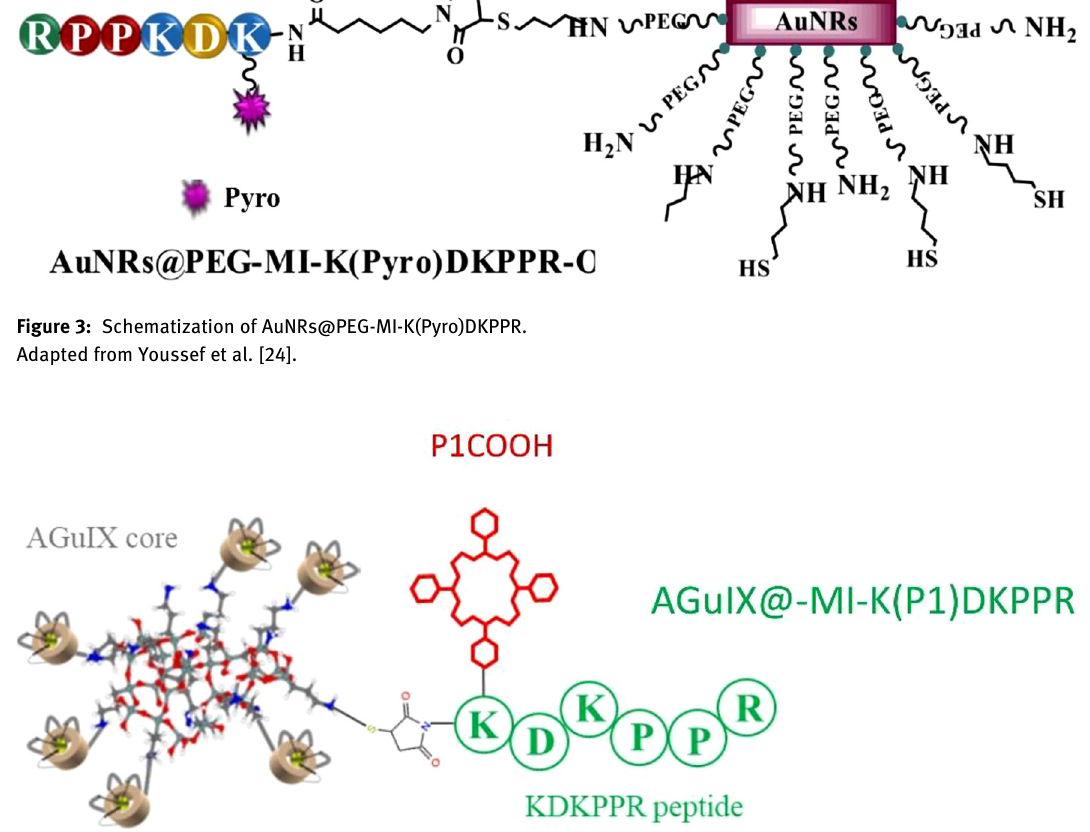
Figure 4: Schematic presentation of AGuIX@MI-K(P1)DKPPR NPs. Adapted from Thomas et al.